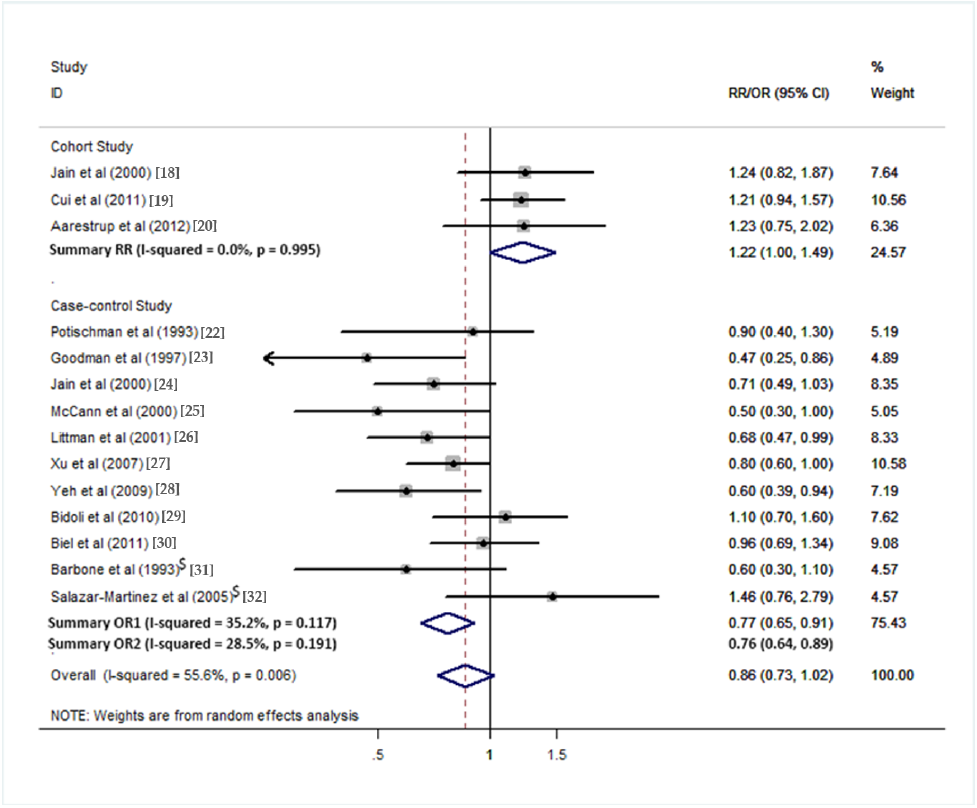
Figure 2. Forest plot of the summary risk estimate of endometrial cancer in the highest category of total dietary fiber intake compared with those in the lowest category. Summary OR1 is the summary risk estimate from all the case–control studies. Summary OR2 is the risk estimate from studies after exclusion. Excluded studies: $ Hospital-based case–control study.